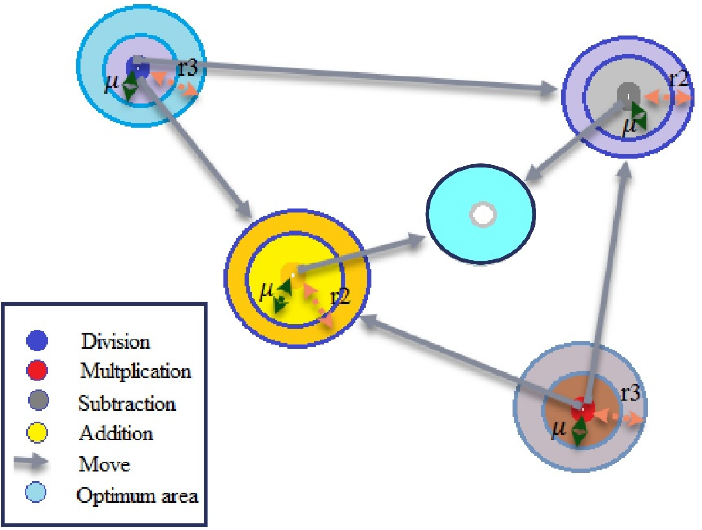
Figure 2. How to update AOA operators to the optimal region adopted from